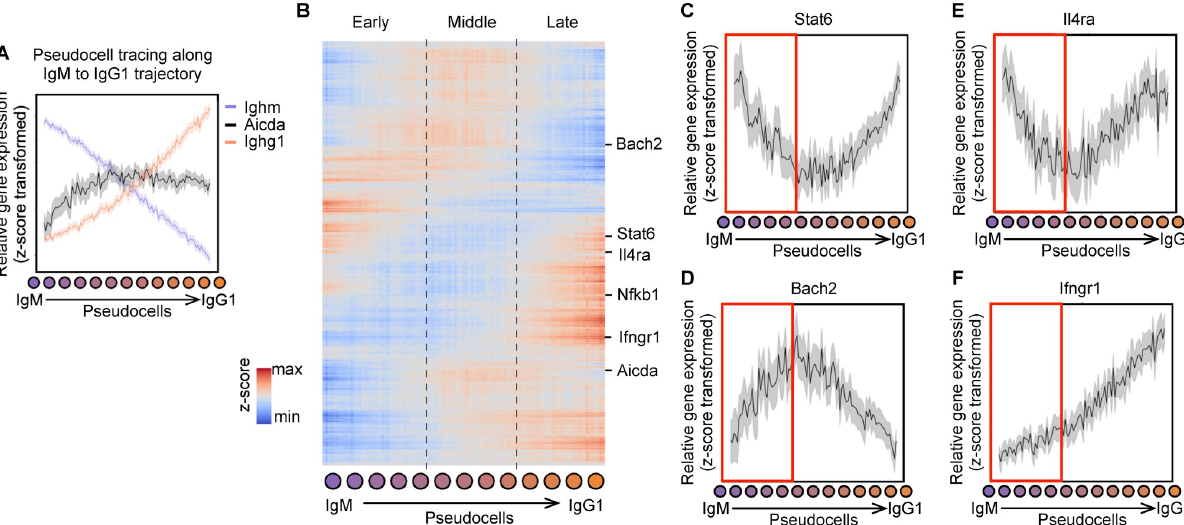
Fig 4. Pseudocell Tracer models IgG1 class switching process. (A) Pseudocells generated along the IgM to IgG1 axis. Plot of relative expression of Aicda , Ighm and Ighg1 along the IgM to IgG1 axis, where solid line indicates average expression and shading indicates 95% confidence interval. (B) Associative clustering of genes during CSR. Regions of early (left), middle (center), and late (right) transcriptional dynamics are depicted. Plots of relative expression for key genes with specific dynamics, including (C) Stat6, (D) Bach2, (E) Il4ra, and (F) Ifngr1.